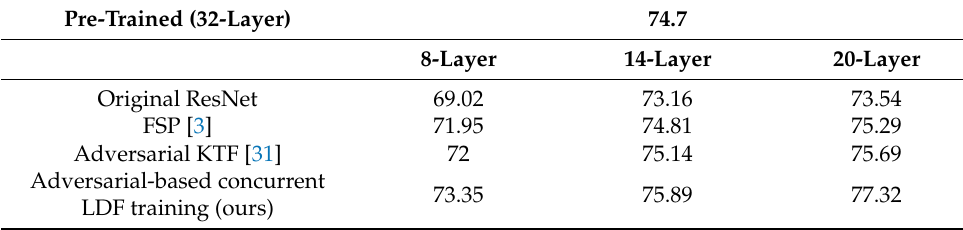
Table 7. Averaged accuracy (%) of CIFAR-100.